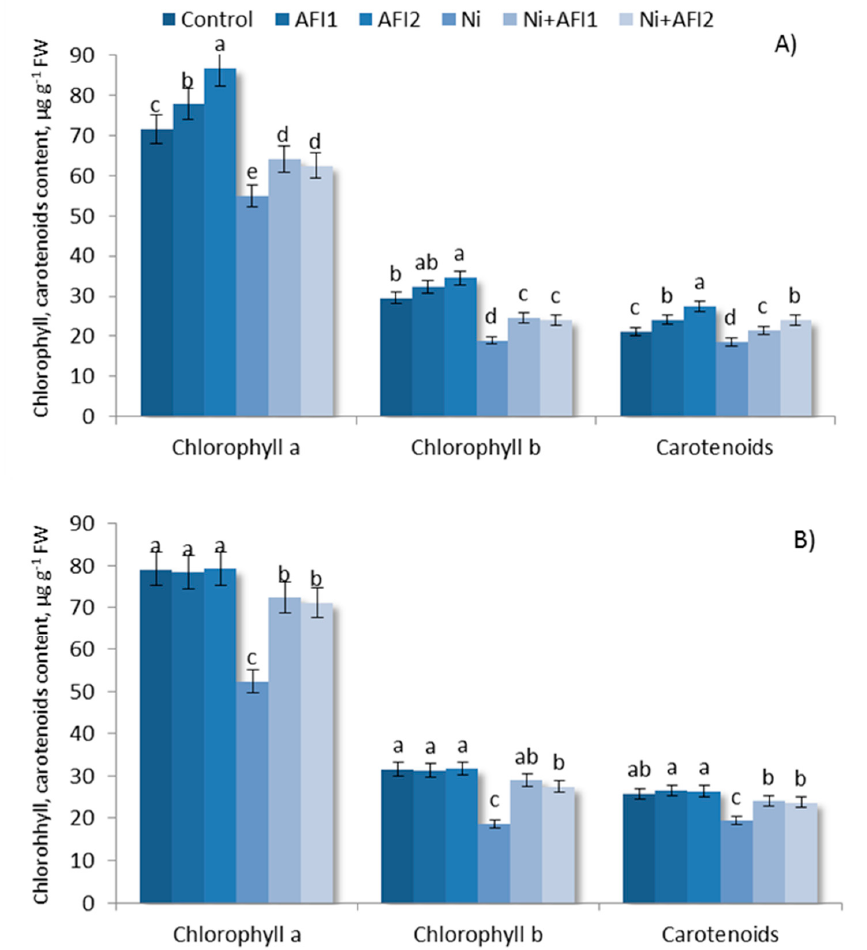
Figure 4. Chlorophylls and carotenoids contents in shoots of wheats: ( A ) Ch. spring S, ( B ) Leningrad. 6 T. Different letters indicate a significant difference between the means at the probability level of p < 0.05, as determined by Duncan’s multiple range